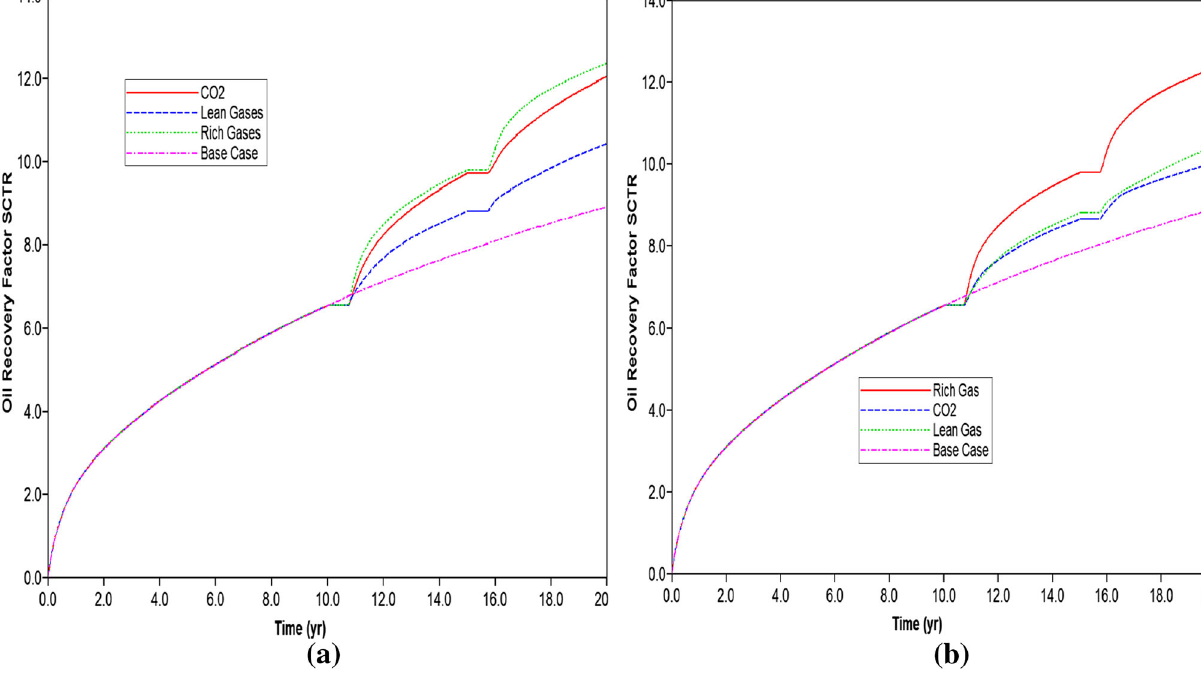
Fig. 16 Miscible gases performance in Bakken model for the 3rd scenario. a Case 1, b